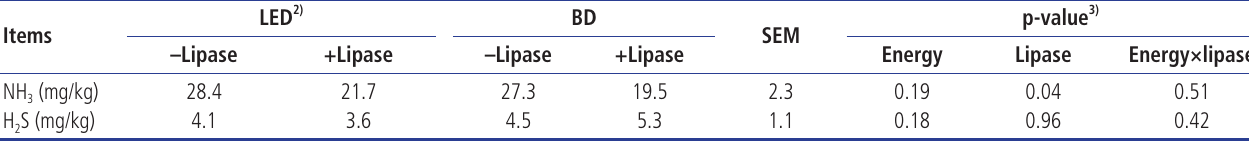
SEM, pooled standard error of the means; NE, net energy. 1) Each mean represents 6 pens (n = 6/group). 2) LED, low energy diet (NE = 2,470 kcal/kg) with or without 1.5 U/g of lipase; BD, basal diet (NE = 2,545 kcal/kg) with or without 1.5 U/g of lipase. 3) Energy, energy effect; Lipase, lipase effect; Energy×lipase, interaction between energy and